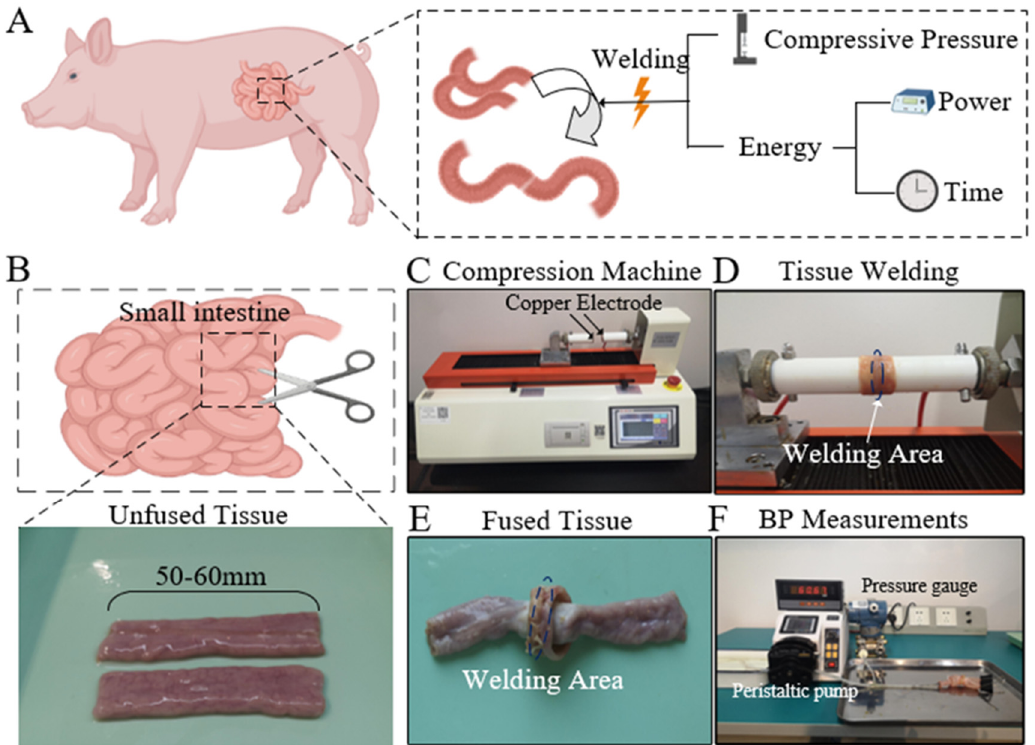
Figure 1. ( A ). Three important parameters in the process of HFEW. ( B ). Small intestine. Fresh small intestine was cut into 50–60 mm segments. ( C – E ). Experimental setups for HFEW induced fusions of the porcine bowel. ( F ). Experimental setup for BP measurements.